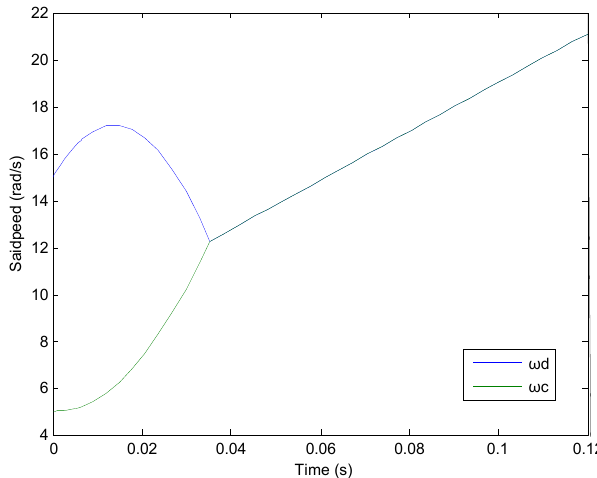
Figure 6. Plots of the revolution speeds when the clutch is engaged.